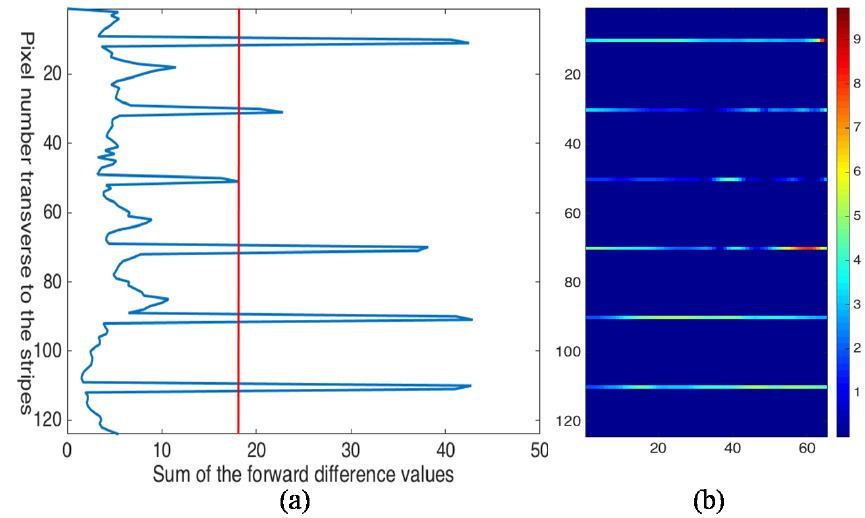
Figure 5. Panel (a) shows the S function values against the column numbers. The peak points represent the stripes. When “threshold” is set at 18, only stripes can be included for the regularization but excludes all the other features of the image. With the units of the image data, the threshold value can written as 842 ◦ Clongitude per latitude. Then the percentage error between the striped and destriped image are shown in the panel (b) . The error where there are no stripes is always closer to the